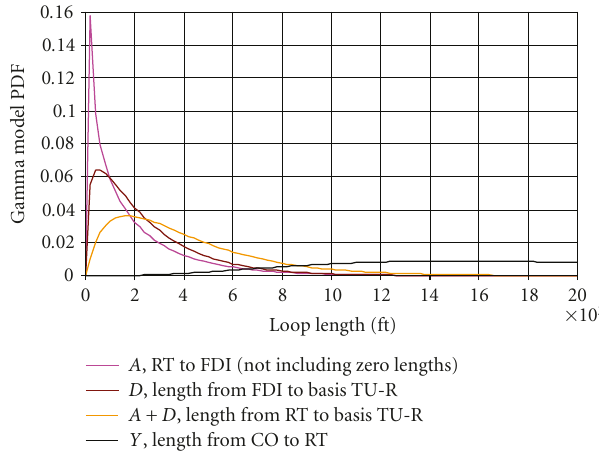
Figure 3: Gamma models of current telephone plant serving area radii [14]. Terminology: central o ffi ce (CO), remote terminal (RT), and feeder-distribution interface (FDI).